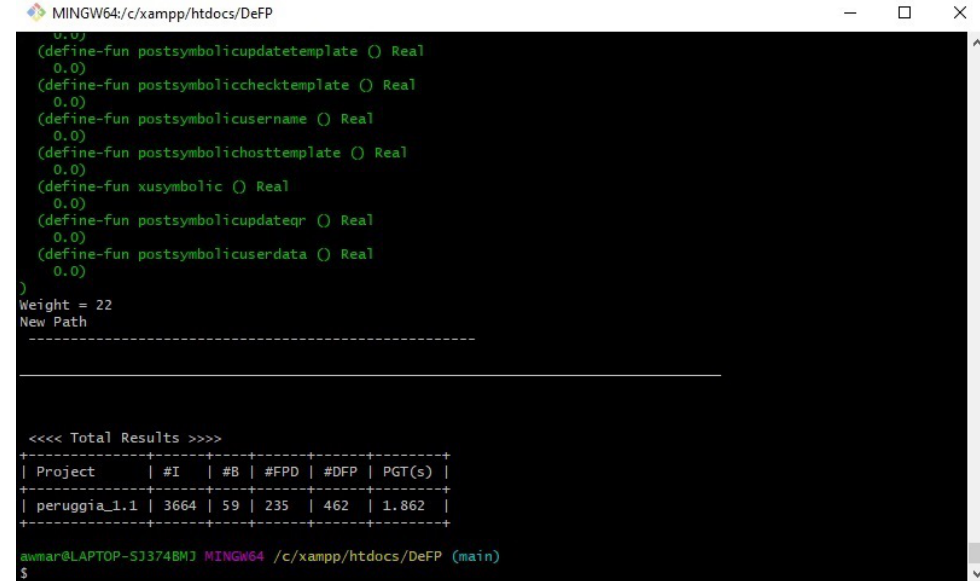
Figure A3. The final results of analyzing the Peruggia